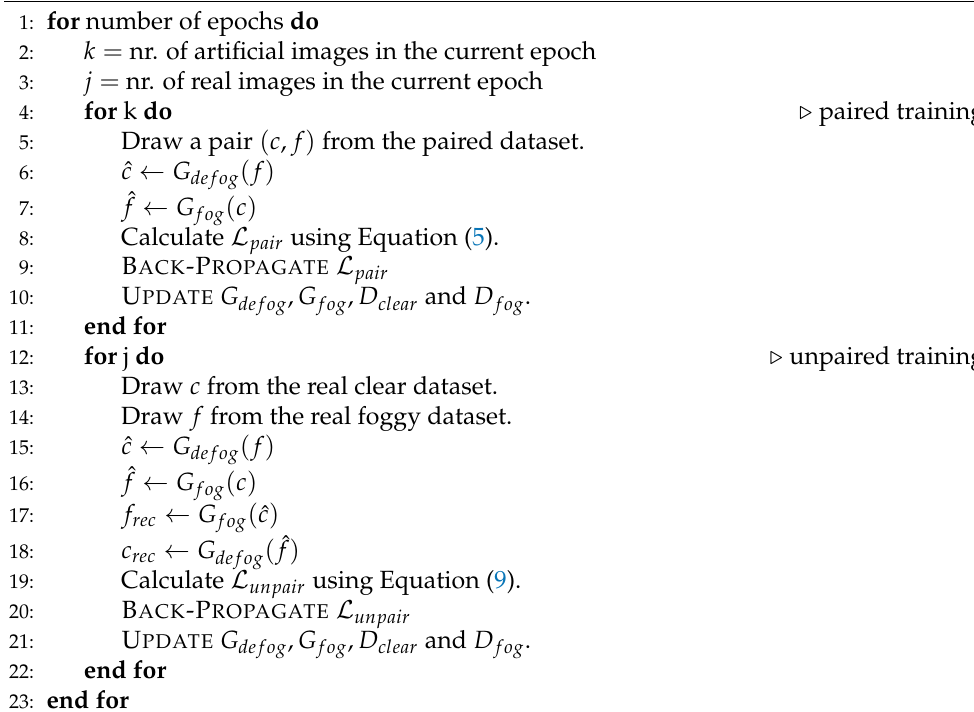
Algorithm 1 CurL-Defog training algorithm. More details are provided in Section 3.3.